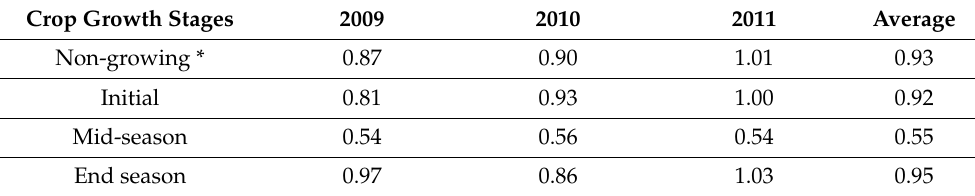
Table 5. Time-averaged single crop coefficients (K c ) for each crop growth stage. Crop Growth